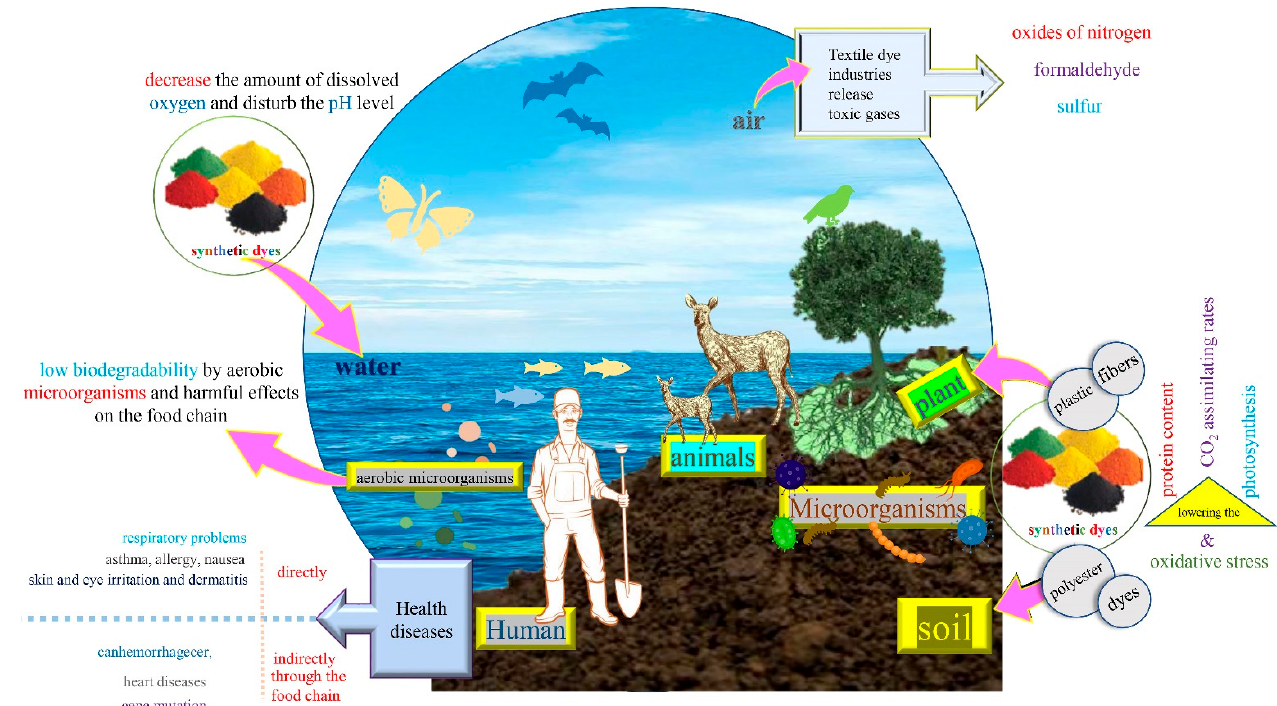
Figure 2. Direct and indirect impacts of textile dyes on several substrates.